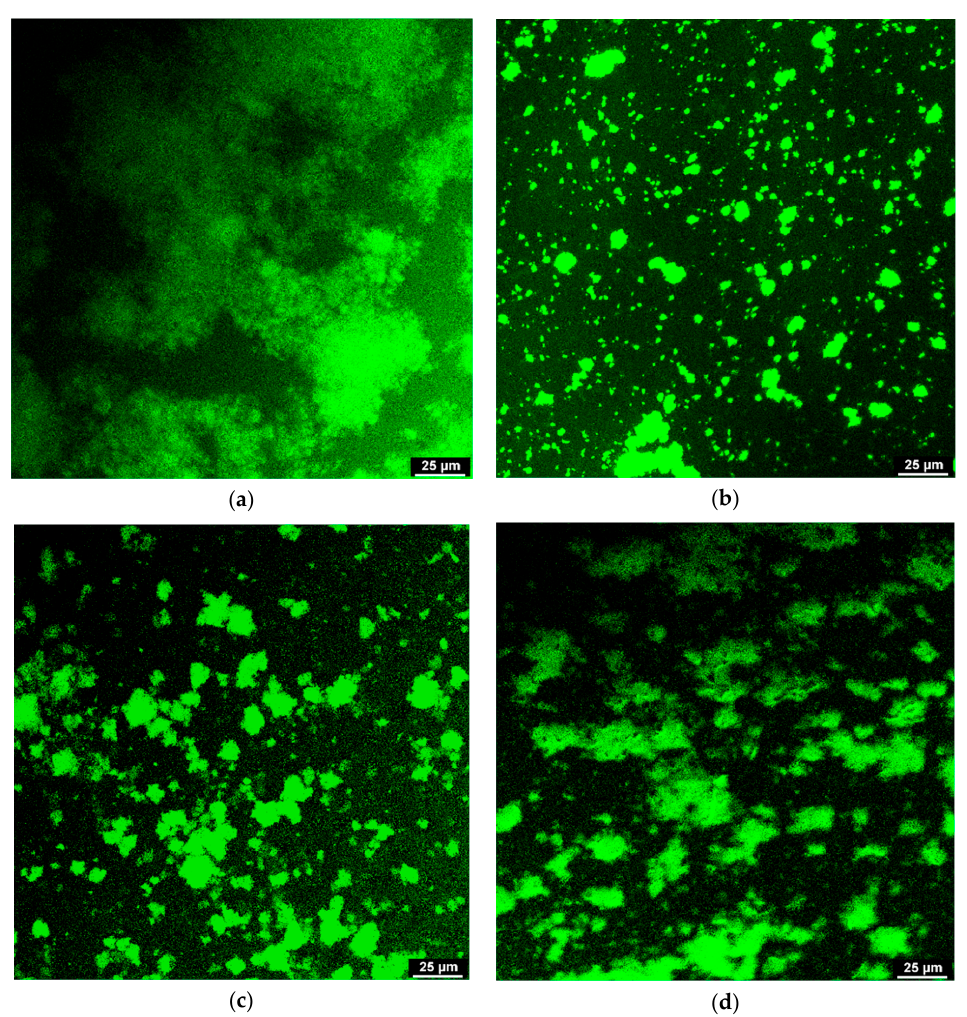
Figure 5. CLSM images of casein flocculates in AMDs prepared without any